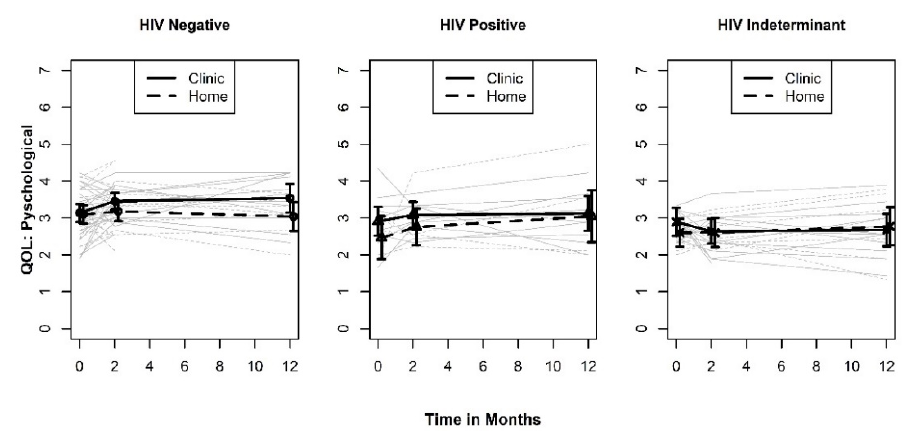
Figure 2. Plots of QOL Psy by HIV test results